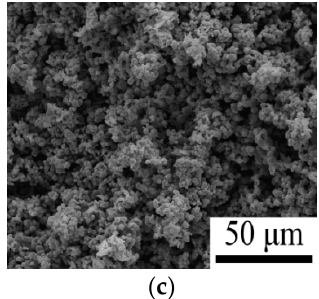
Figure 1. SEM images of ( a ) Ti, ( b ) TiB 2 , and ( c ) Mo powders.